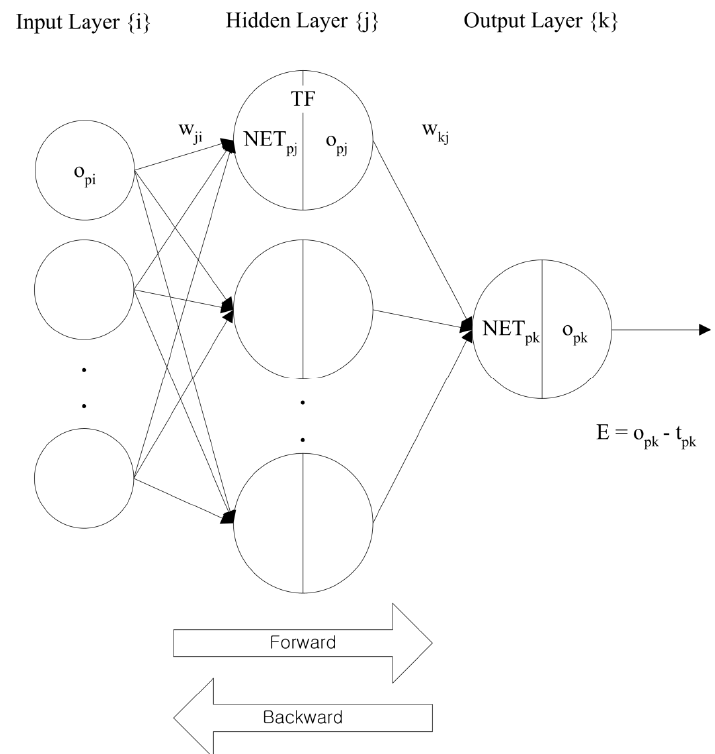
Figure 2. A basic structure and processes of an artificial-neural-network (ANN)